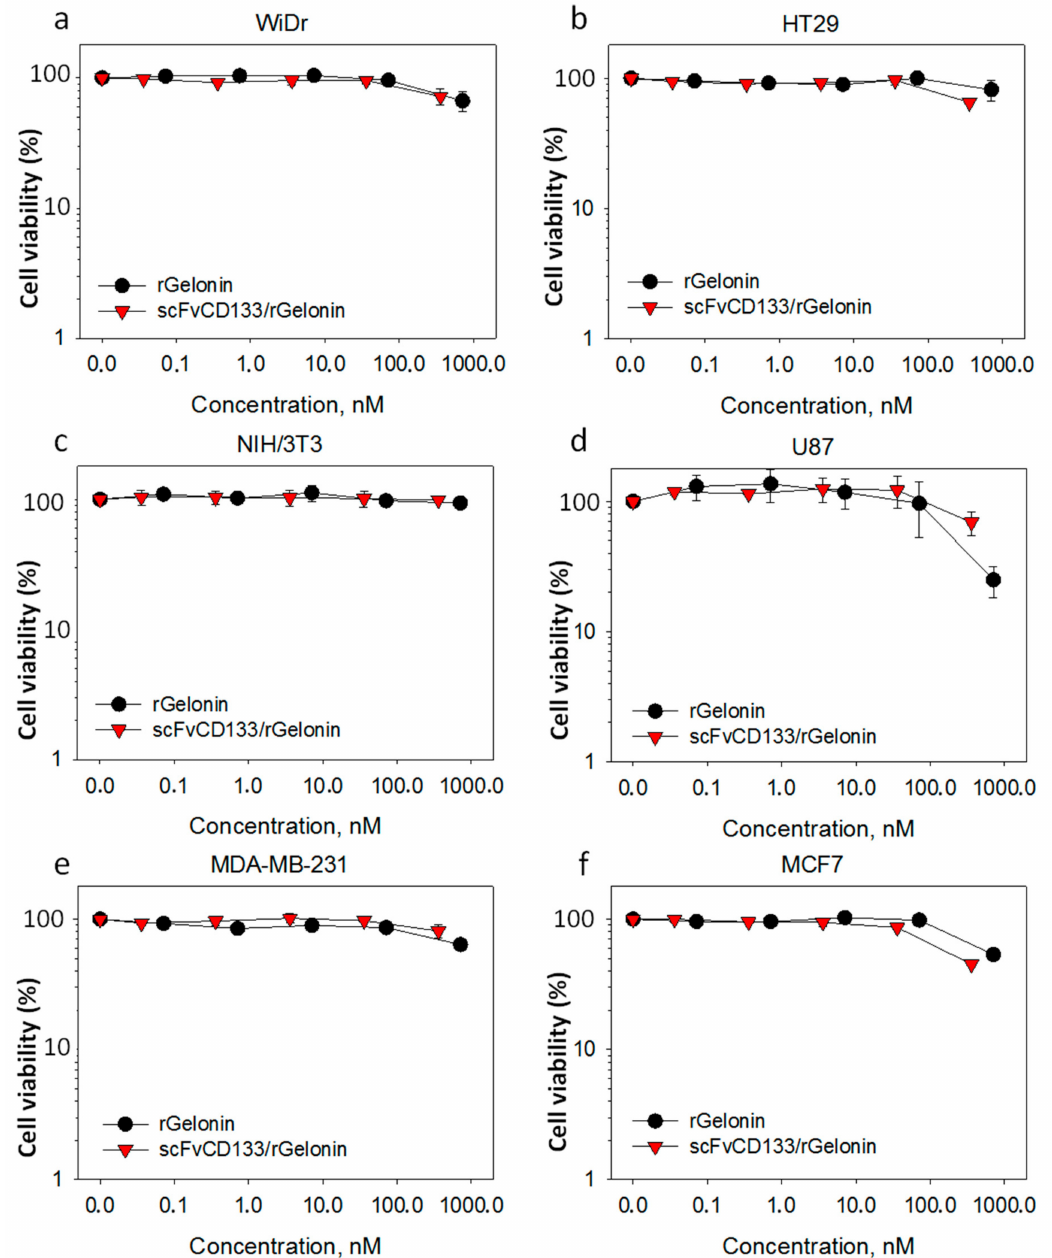
Figure 3. Cytotoxic e ff ects of free rGelonin versus scFvCD133 / rGelonin without PCI. Cytotoxicity was assessed in six di ff erent cell lines, including WiDr ( a ), HT29 ( b ), NIH / 3T3 ( c ), U87 ( d ), MDA-MB-231 ( e ), and MCF-7 ( f ) by the MTT viability assay 72 h after incubation with increasing concentrations of rGelonin or scFvCD133 / rGelonin. The data are the mean of two individual experiments. Some of the error bars are smaller than the symbol size. Error bars =